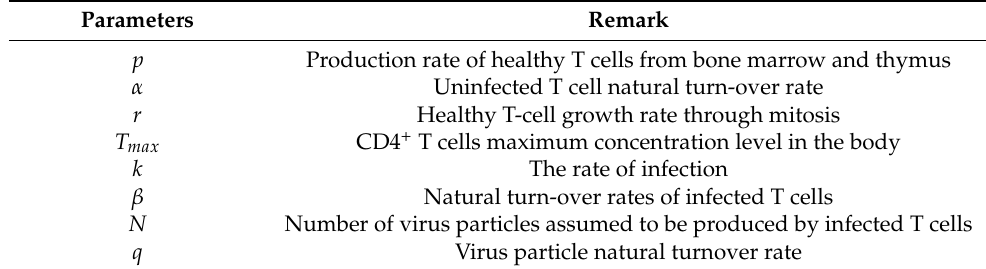
Table 1. List of parameters used in the HIV infection model.